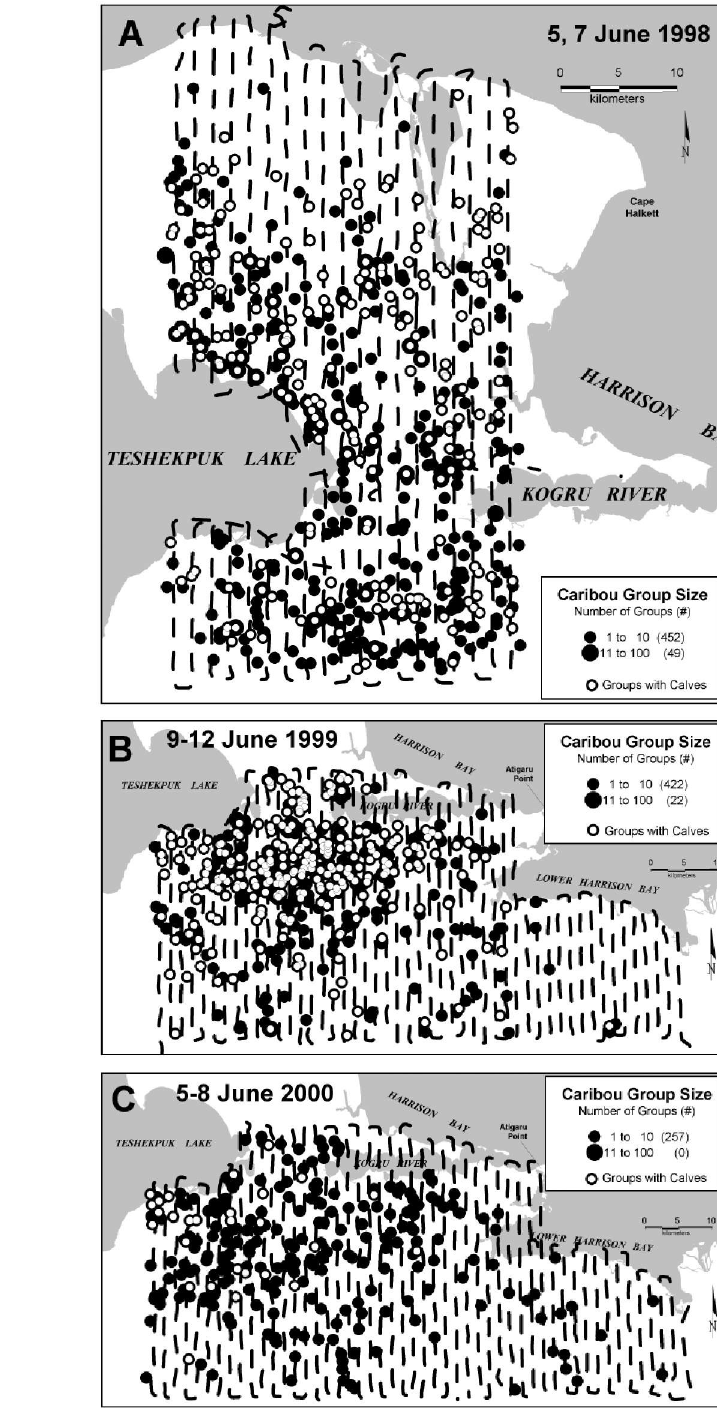
Fig. 3. Caribou groups located during 100% coverage systematic aerial strip-transect surveys in the National Petroleum Reserve— Alaska, June